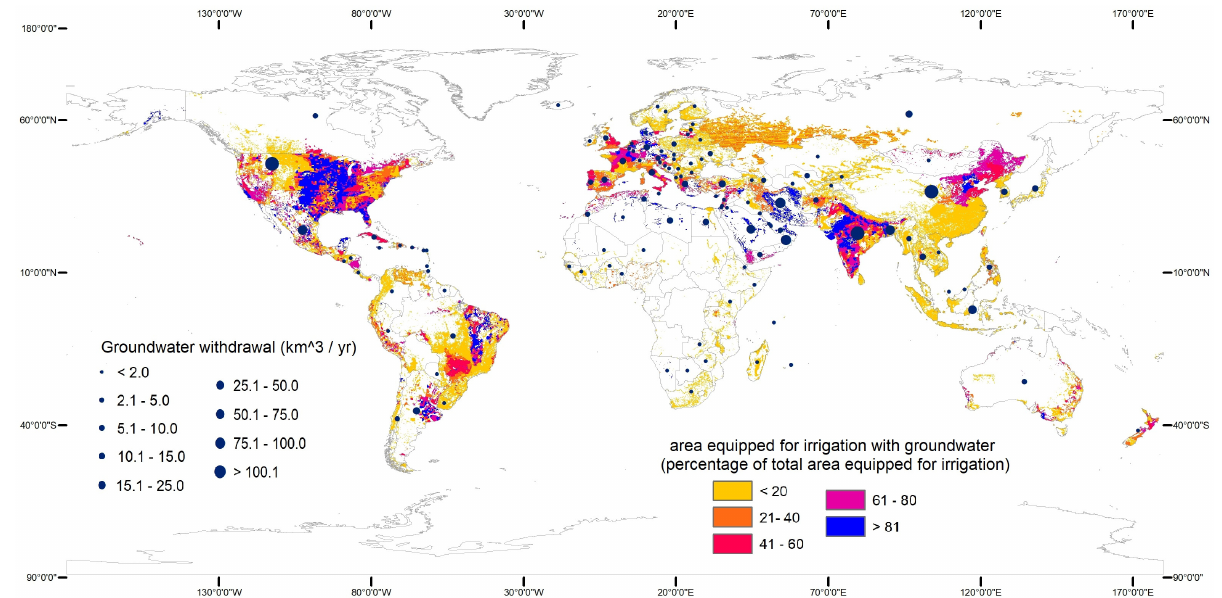
Figure 14. Groundwater withdrawal and an area equipped for irrigation with groundwater (data source [232] ).